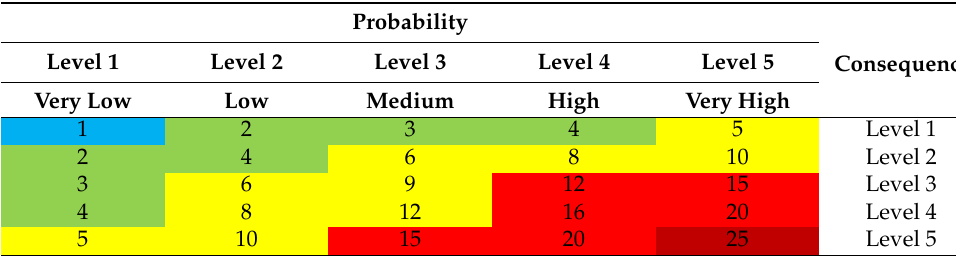
Table 4. Risk matrix.